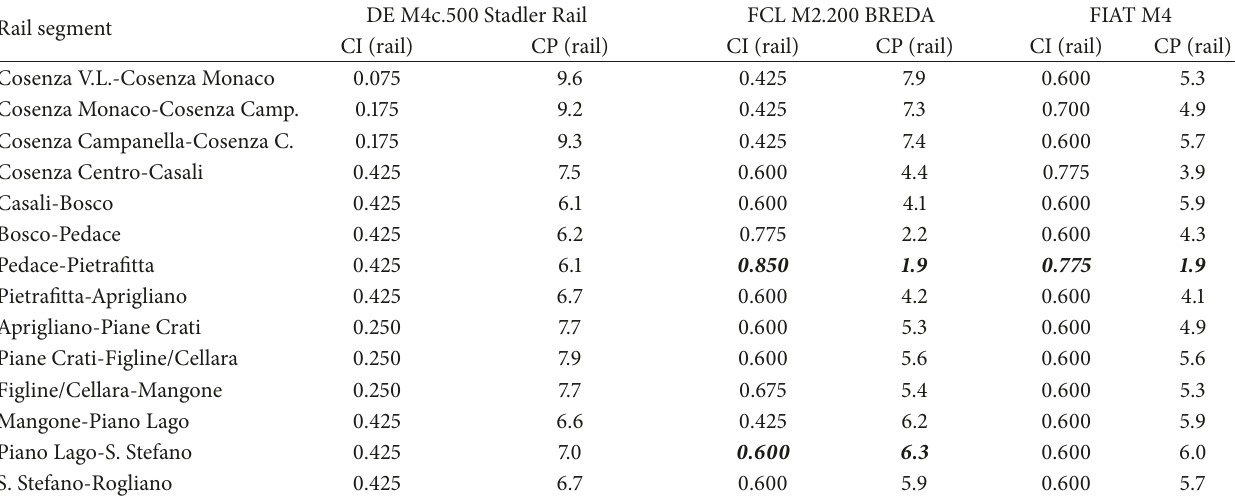
Figure 12: Reliefs georeferencing on GIS. Table 6: Calculation of CI (rail) and CP (rail) on the test site Cosenza Vaglio Lise-Rogliano (i th